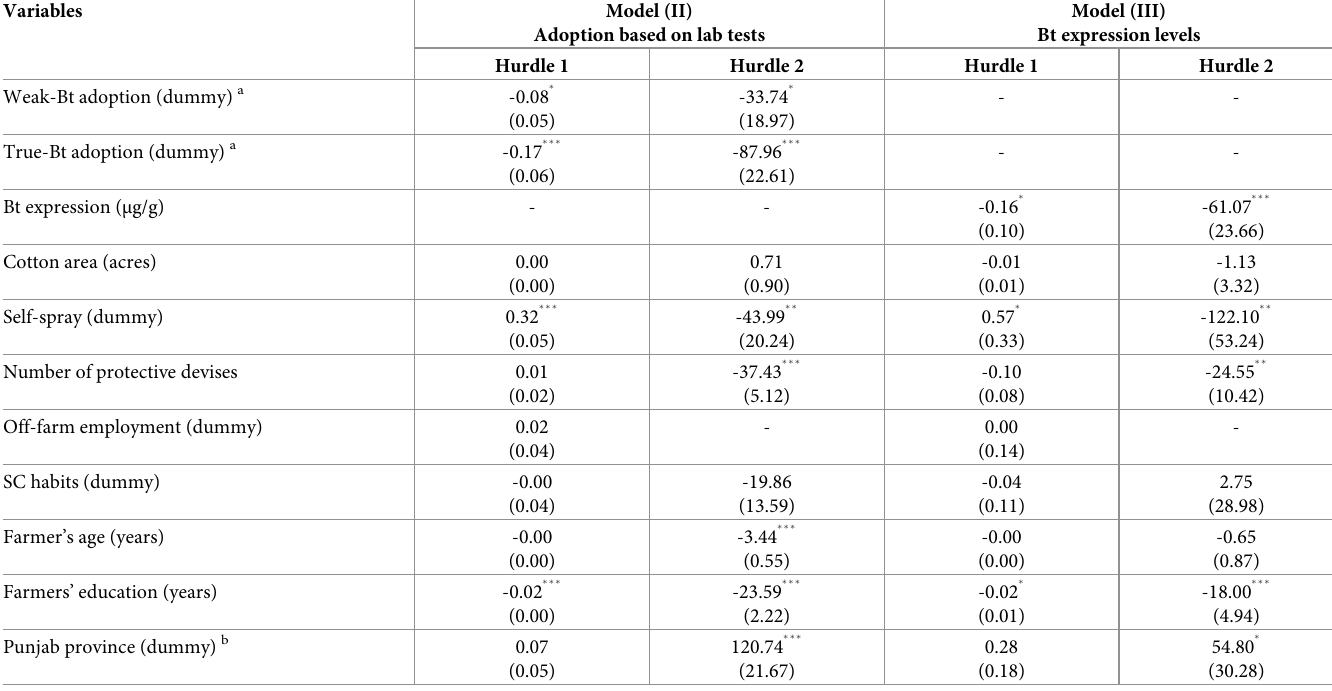
Table 6. Conditional marginal effects from double-hurdle models.